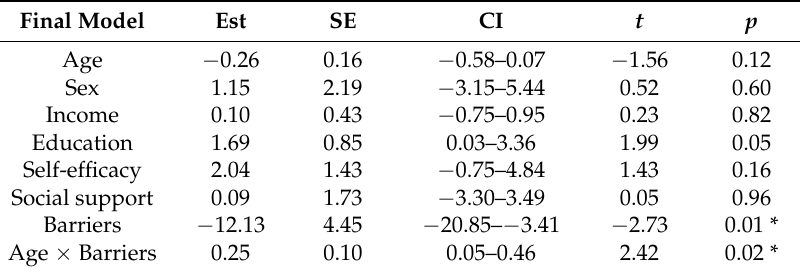
Table 7. Linear regressions predicting HEI scores ( n =